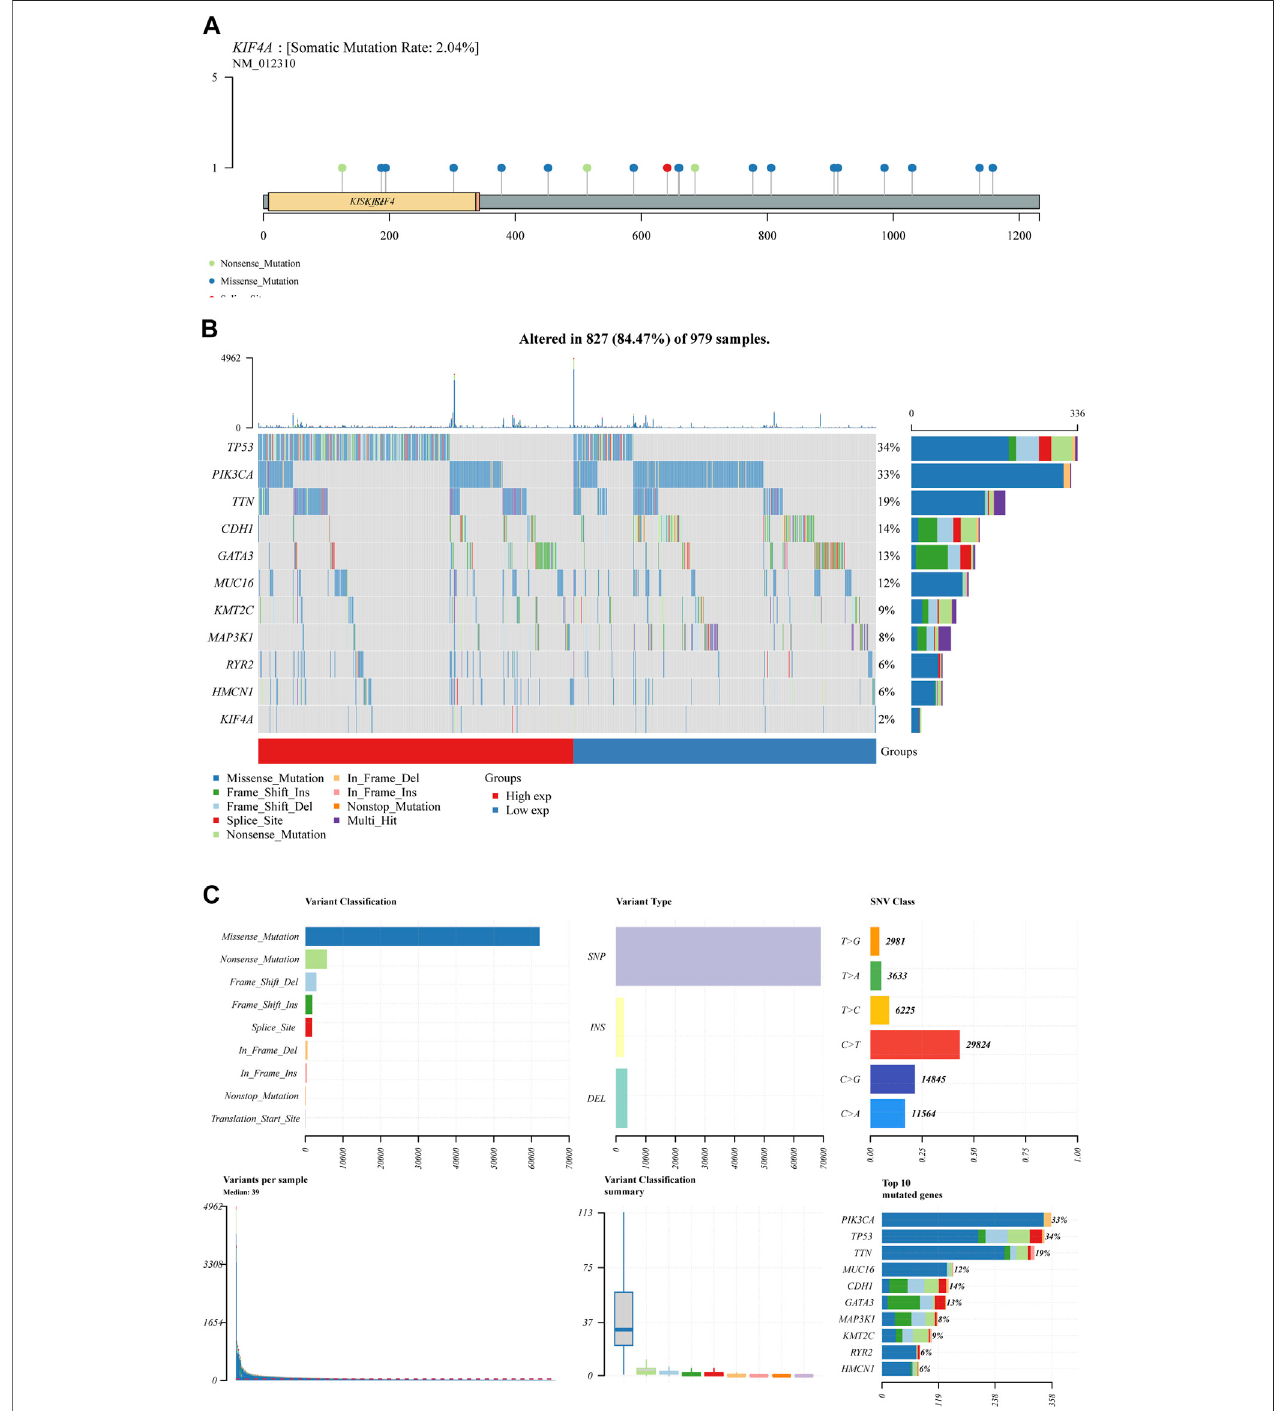
FIGURE 7 | BC mutation cohorts in TCGA datasets. (A,B) Waterfall diagram depicting the TCGA BC cohort ’ s top 10 most frequently mutated genes, including KIF4A. (C) Overview of mutations in all BC samples.